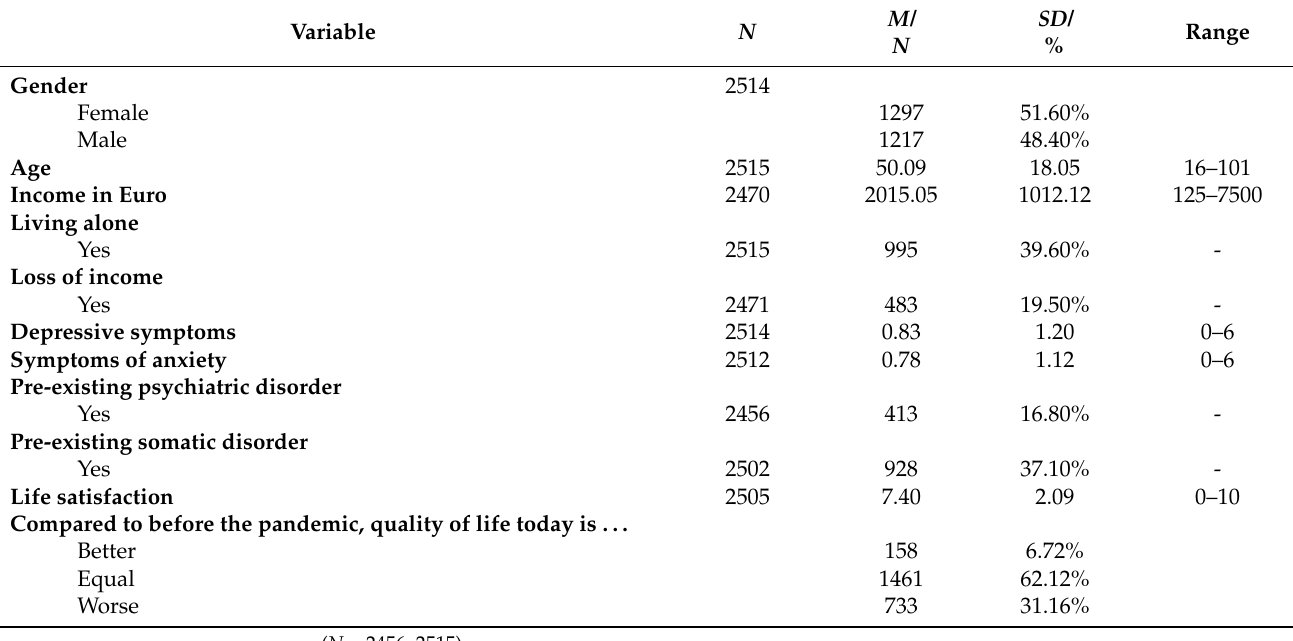
Table 1. Sample characteristics.